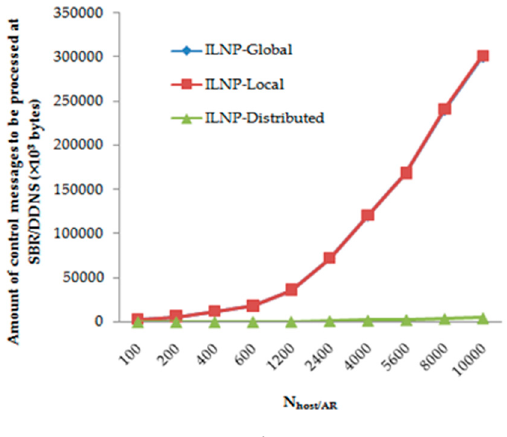
Figure 17. Impact of N Host / AR on CTO.